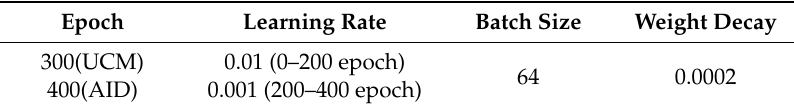
Table 1. Hyperparameter settings of the